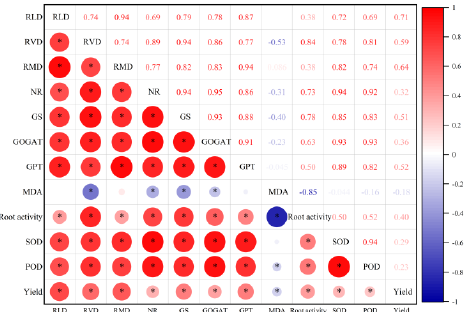
Figure 8. Interrelationship of root system indicators in drip-irrigated spring wheat. RLD: Root length density; RVD: Root volume density; RMD: Root mass density; NR: Nitrate reductase; GS: Glutamine synthetase; GOGAT: Glutamate synthase; GPT: Glutamic pyruvic transaminase; MDA: Malondialdehyde; SOD: Superoxide dismutase; POD: Peroxide dismutase; “*” indicates significant